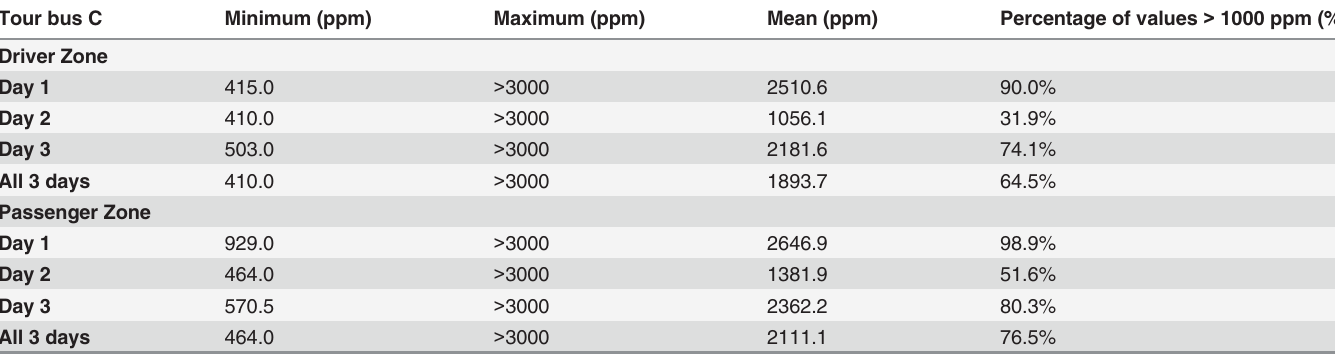
Table 3. Results of CO 2 concentration monitored in tour bus C under real-time traffic conditions.